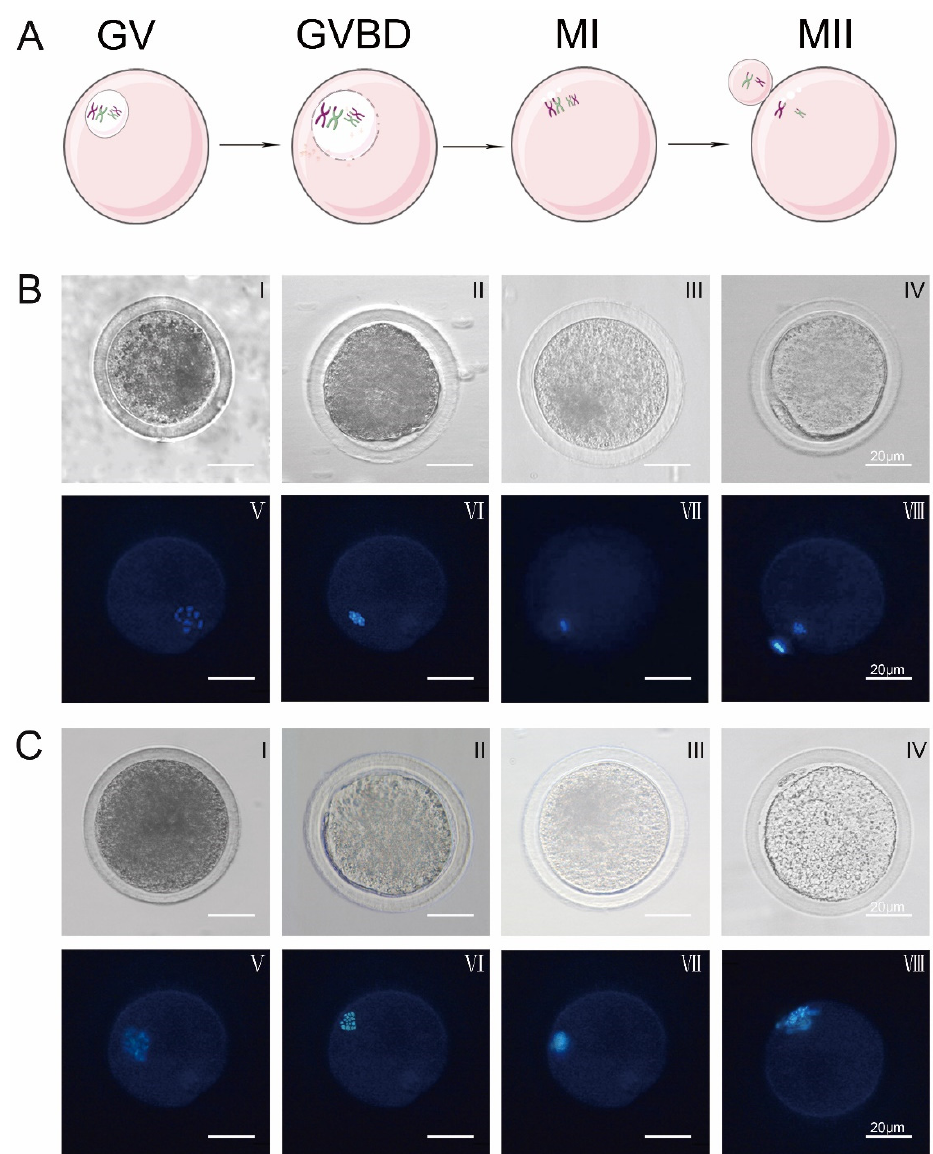
Figure 1. Changes in oocyte nuclear morphology over time in response to ghrelin. ( A ) Diagram of different stages of IVM oocytes (GV, GVBD, MI, MII). ( B ) Control group: (0 ng/mL) oocyte nuclear maturation cell morphology (I–IV) and Hoechst 33342 stained cell morphology (V–VIII) (scale bar: 20 µ m) ( C ) Experimental group: (200 ng/mL) oocyte nuclear maturation cell morphology (I–IV) and Hoechst 33342 stained cell morphology (V–VIII) (scale bar: 20 µ m).